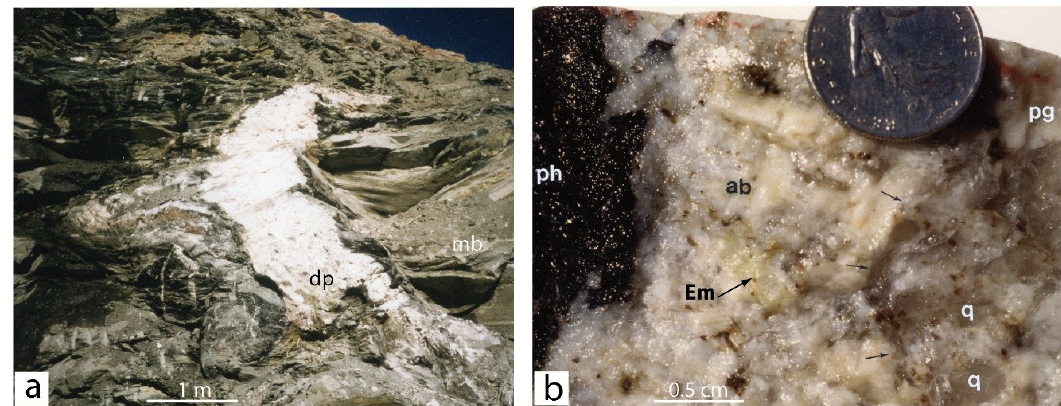
Figure 13. Desilicated emerald-bearing pegmatites: ( a ) Desilicated pegmatites crosscutting metabasites (mb) from the Kafubu mine (Zambia). Photograph: Dietmar Schwarz; ( b ) desilicated pegmatite from the Carna í ba mine, Brazil. At the contact of a pegmatite (pg) and a serpentinite, the metasomatic fluid dissolved quartz, mobilized Cr and V from the chromite-bearing serpentinite, and Be from the beryl-bearing pegmatite to form emerald (Em). The fluid transformed the serpentinite into a phlogopitite (ph) and the pegmatite in an albite-rich rock (ab). The three arrows indicate the limit of the dissolution of quartz (q) from the pegmatite. Photograph: Gaston